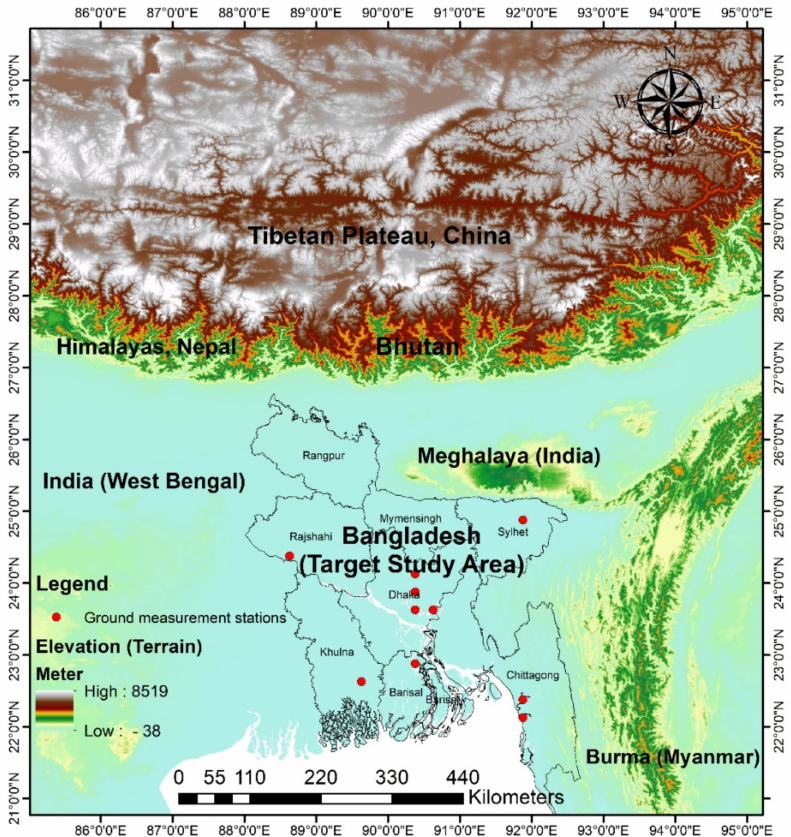
Figure 1. Geographical location of the study area, along with its surroundings. The background of the figure shows the